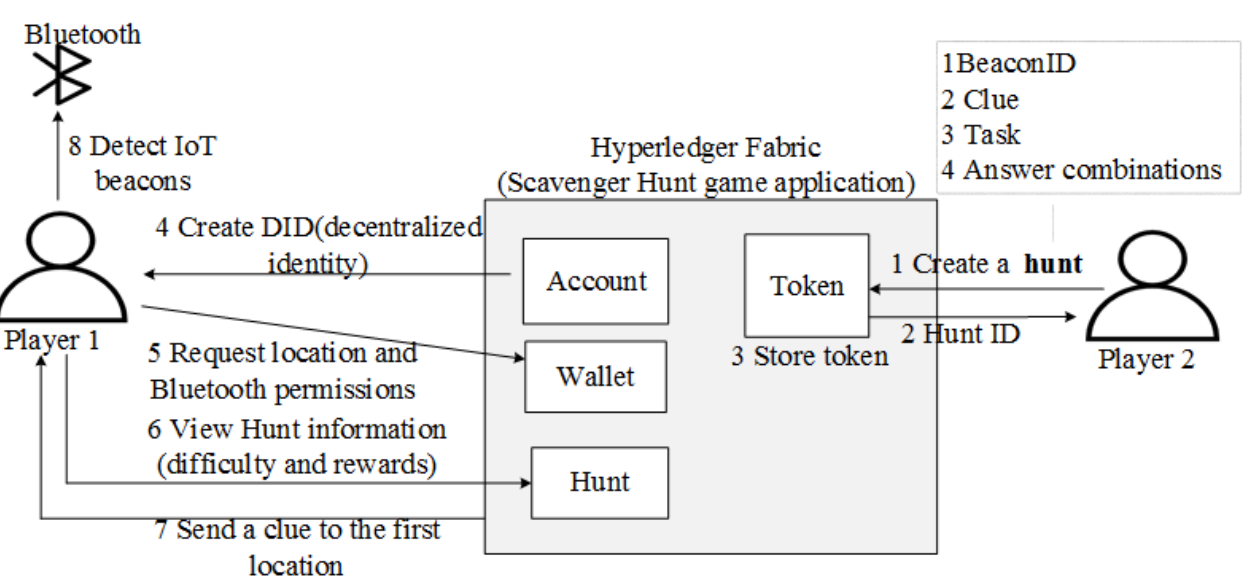
Figure 22. Reconstruction diagram of reference [48].